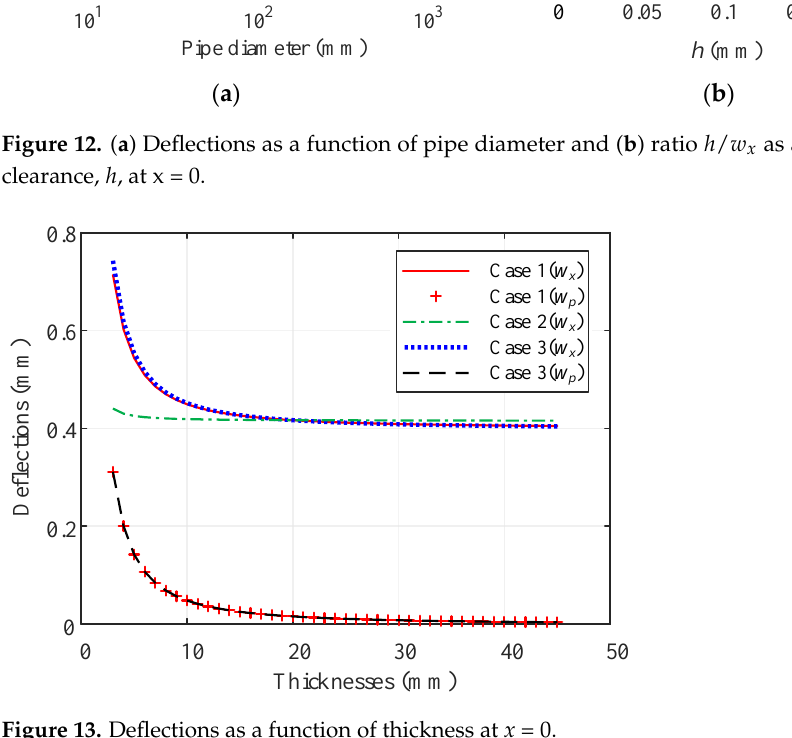
Figure 13. Deflections as a function of thickness at x = 0.